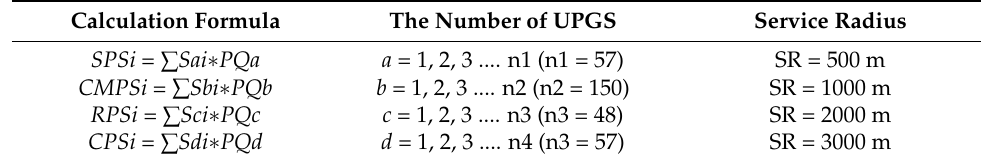
Table 6. A formula for calculating the supply of UPGS within a sub-district.